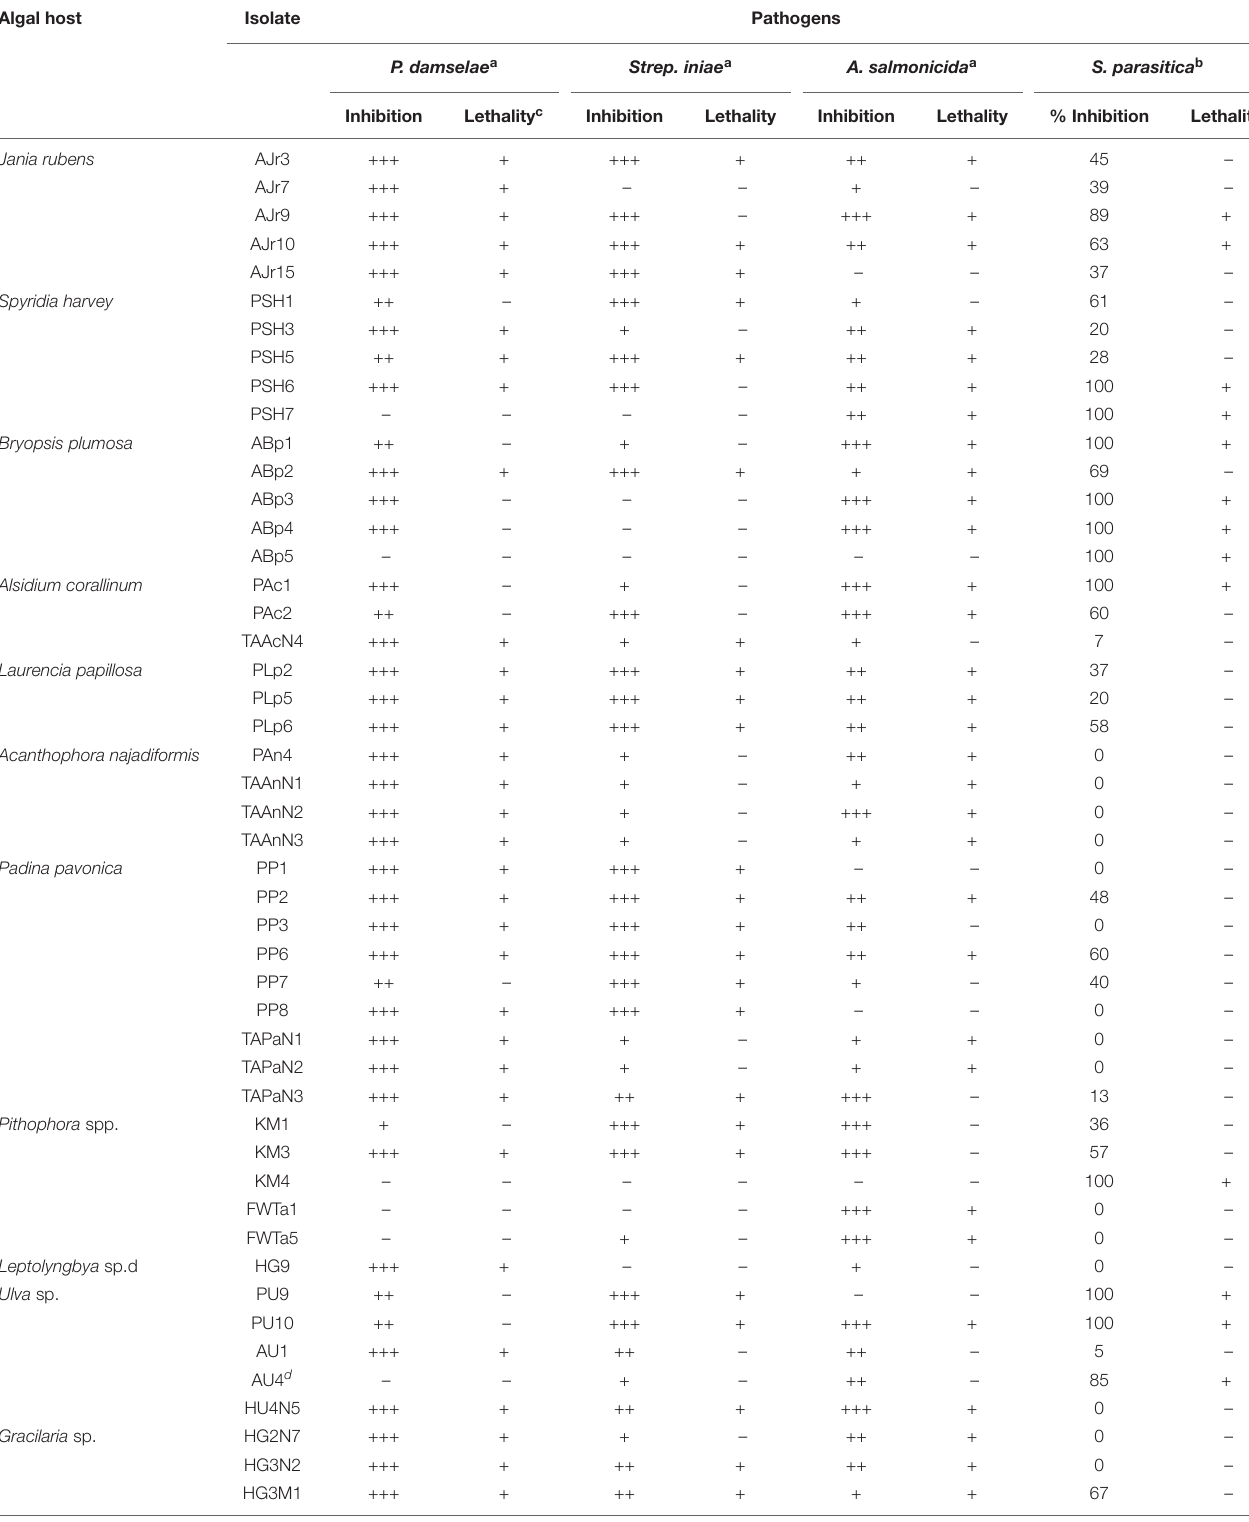
TABLE 2 | Highly active endophytes from different algae, sorted by their ability to inhibit and/or kill the four major aquaculture pathogens. Algal